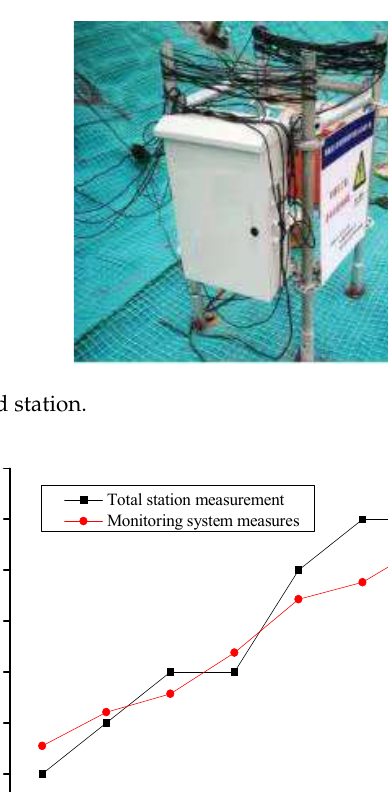
Figure 10. Layout of measuring points for slope horizontal displacement.